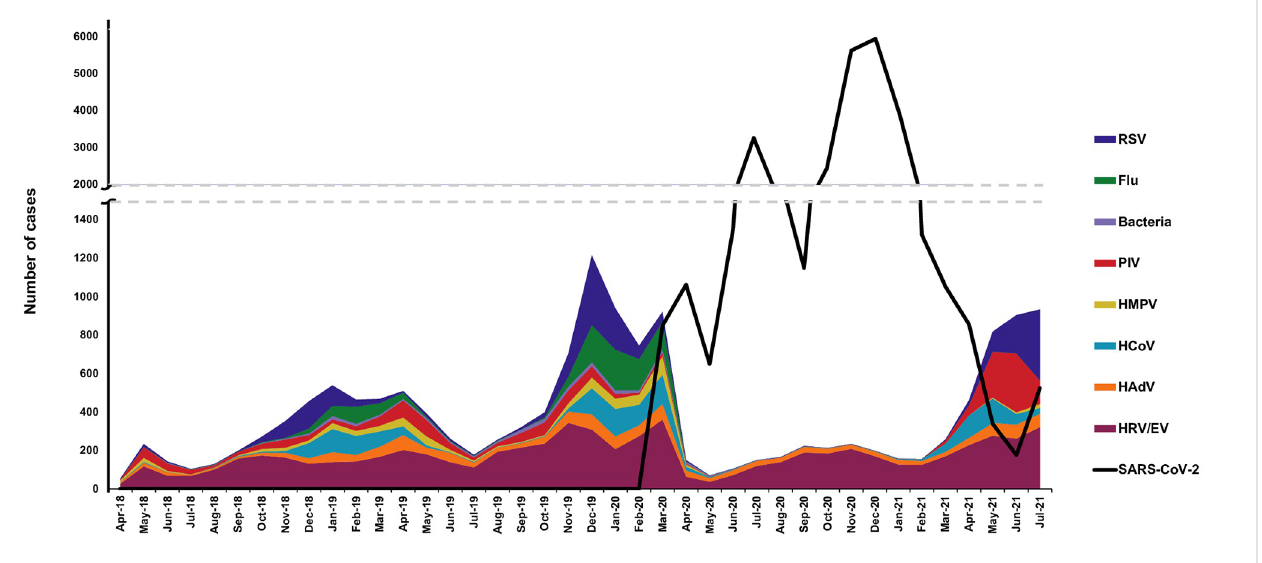
Fig 1. Frequency of respiratory pathogens from April 1, 2018, through July 31, 2021. Abbreviations: RSV, respiratory syncytial virus; Flu, influenza; PIV, parainfluenza virus; HMPV, human metapneumovirus; HCoV, human coronaviruses; HAdV, human adenovirus; HRV/EV, human rhinovirus/enterovirus; SARS-CoV-2, severe acute respiratory syndrome coronavirus 2.